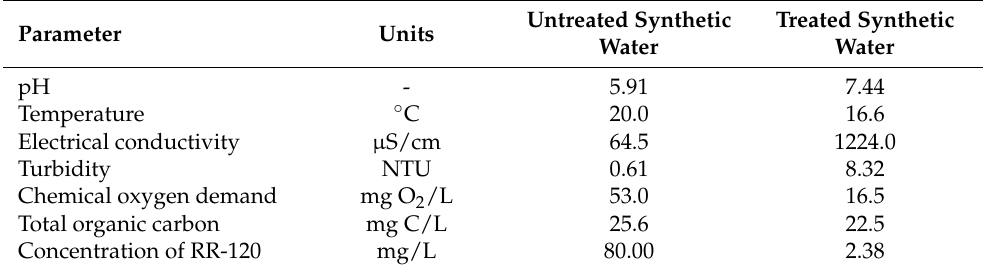
Table 2. Physical–chemical and chemical characteristics of the untreated and treated synthetic water from the textile